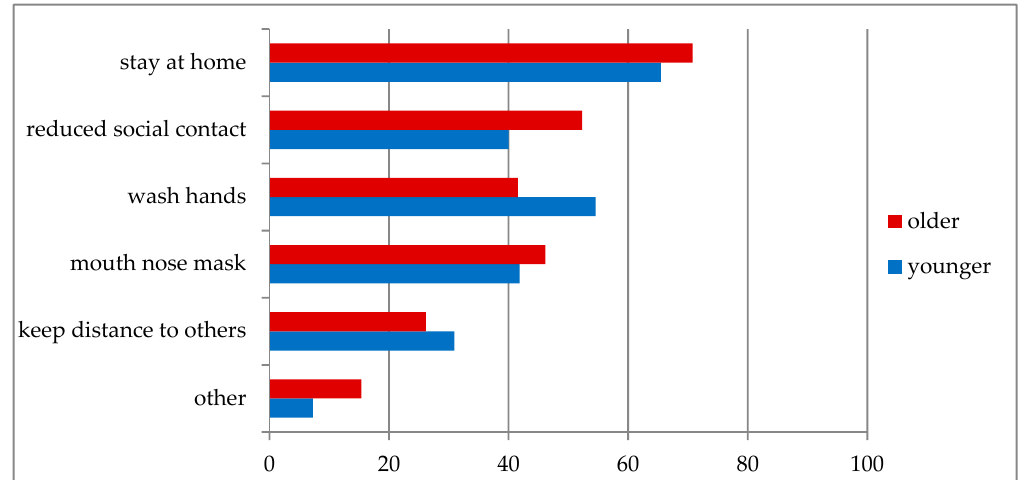
Figure 2. Actively reported preventive measures in response to COVID-19 (%).